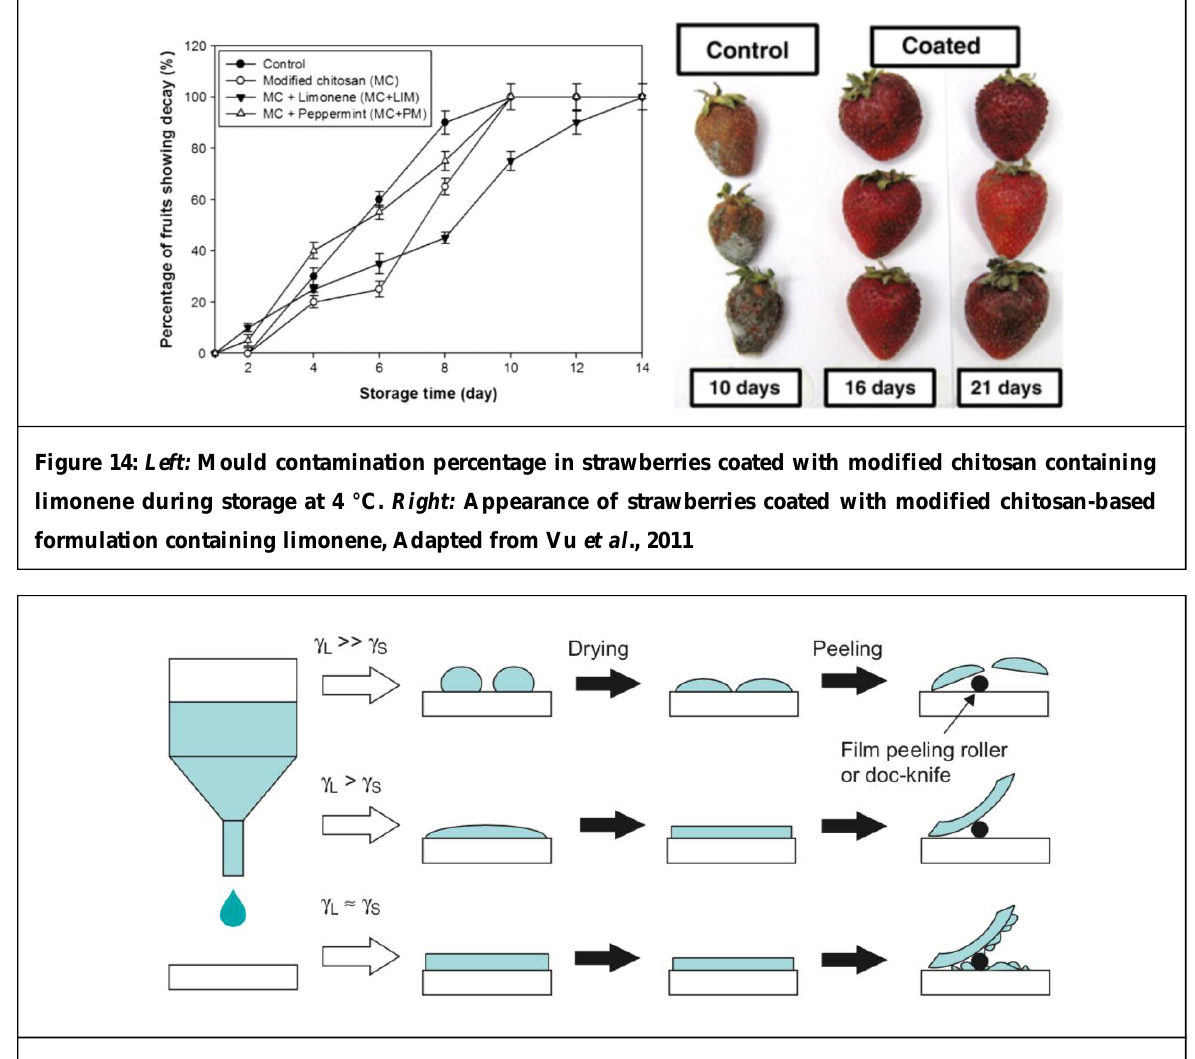
Figure 15: Effect of surface tension (  L) of coating solution on the adhesion of films during a film-forming process. Retrieved from ch. 9 p. 239, Han,